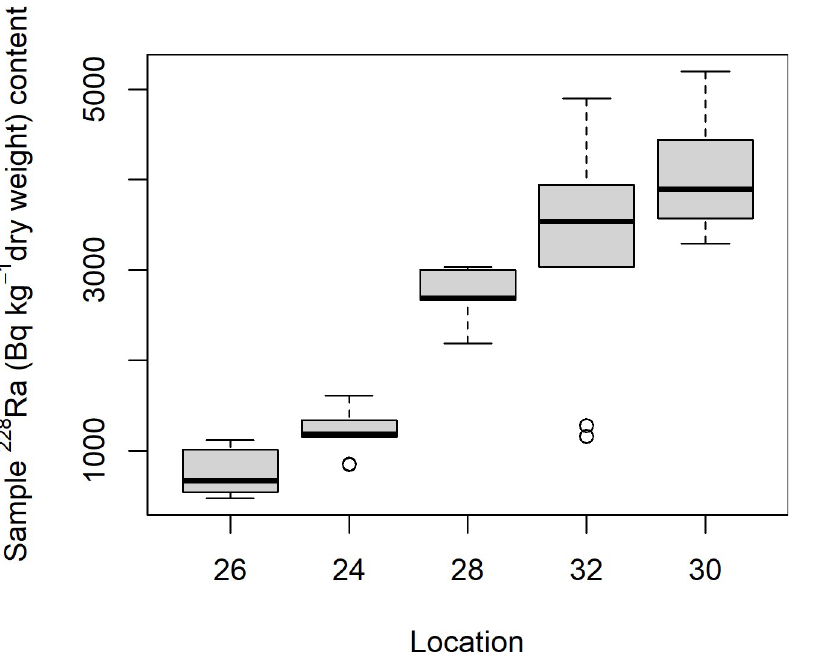
Fig 7. Boxplot of 228 Ra (Bq kg -1 d.w.) of soil samples among localities within Mining hill. https://doi.org/10.1371/journal.pone.0247793.g007 The log -transformed 228 Ra levels were weakly correlated to log 10 226 Ra (r = 0.41, p < 0.01), negatively weakly correlated to log p < 0.02) but not to log -transformed soil pH (r = -0.13, p > 0.4). The log 10